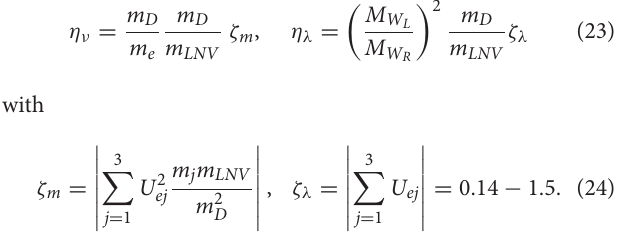
Here, m D represents energy scale of charged leptons and m